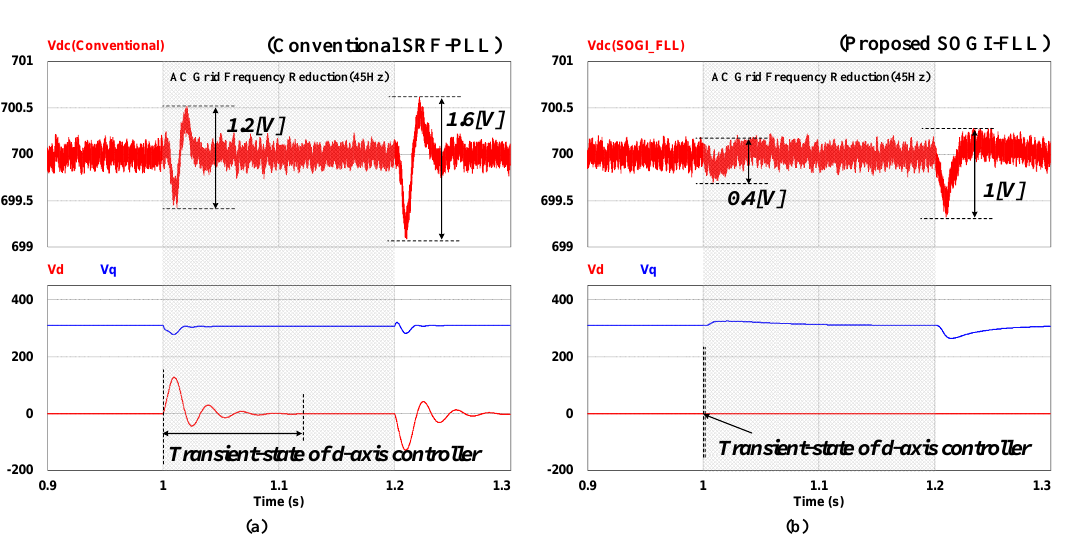
Figure 21. Waveforms of simulation results when frequency suddenly change ( a ) the DC-link voltage, d and q-axis voltage in synchronous reference frame with conventional synchronous reference frame-phase locked loop (SRF-PLL) ( b ) the DC-link voltage, d and q-axis voltage in synchronous reference frame with proposed control method.